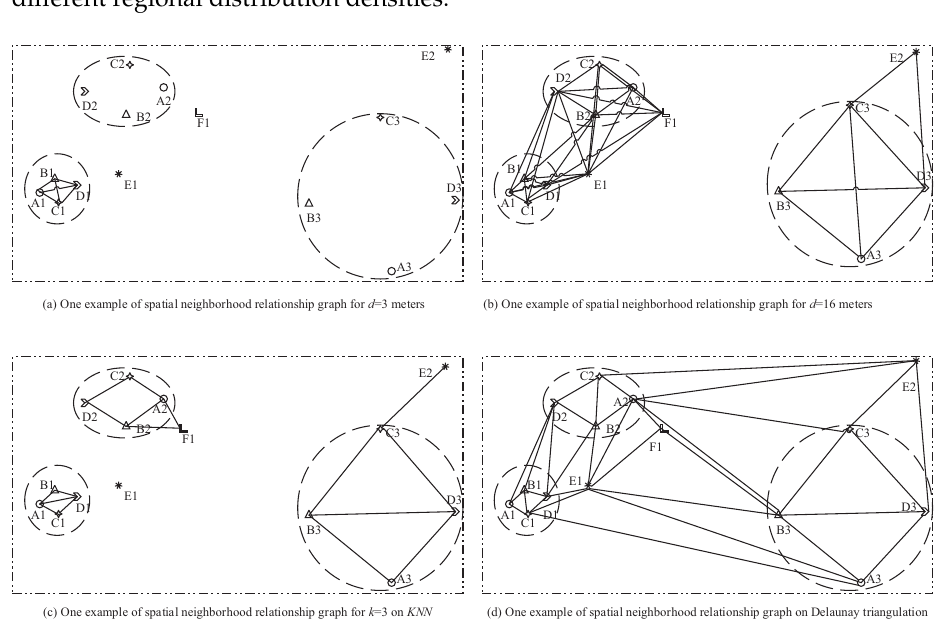
Figure 1. This is a toy example of spatial data sets. Each letter represents a feature and its following number does an instance of the feature. The coordinate accuracy is in meters. ( a ) The neighbor relationship graph on distance threshold way when the given distance threshold d = 3 m. ( b ) The neighbor relationship graph on distance threshold way when the distance threshold d = 13